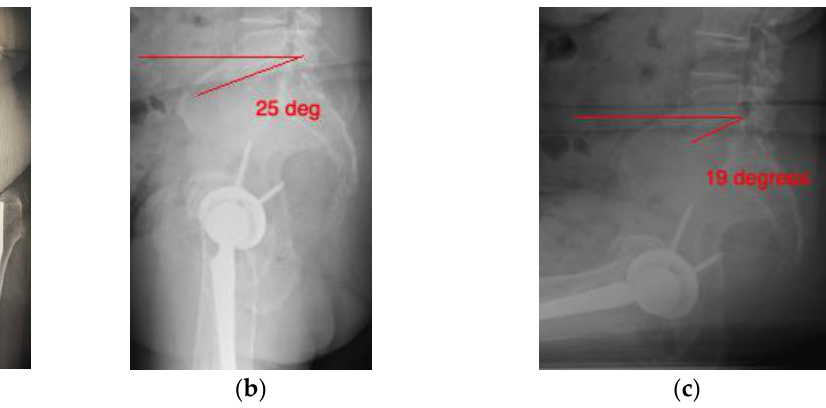
Figure 6. ( a ) AP pelvis radiograph; ( b ) standing lateral lumbar radiograph showing sacral slope of 25 degrees; ( c ) sitting lumbar radiograph showing sacral slope of 19 degrees.